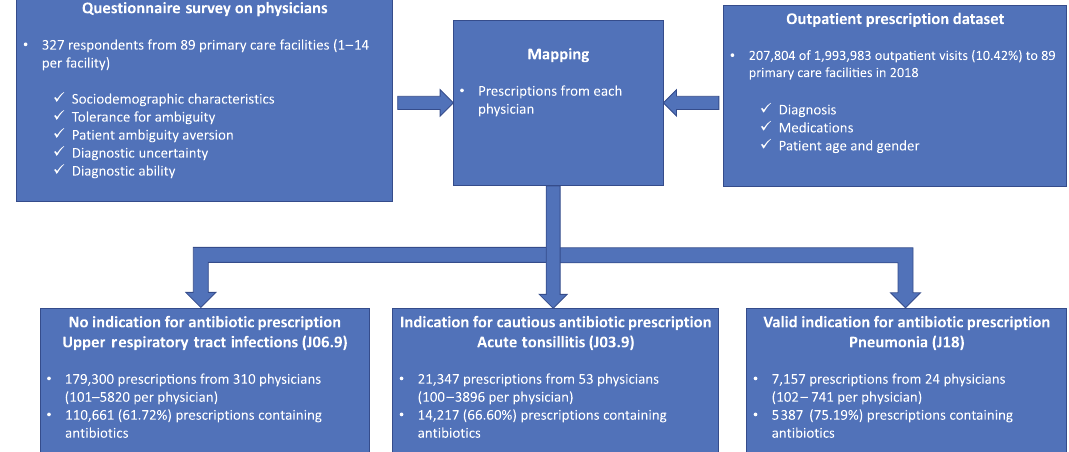
Fig. 1 Data collection and extraction procedure. This fi gure shows the current study design. Physicians ’ characteristics regarding diagnostic uncertainty were collected by a questionnaire survey, and their antibiotic-prescribing behaviours in clinical practice were extracted from the outpatient prescription dataset. The surveyed characteristics of physicians were mapped with their prescriptions for three acute conditions commonly treated in primary care facilities, including upper respiratory tract infections, acute tonsillitis, and pneumonia with an unspeci fi ed organism. According to the guidelines, antibiotics are not recommended for URTIs, while cautious use of antibiotics can be applied for tonsillitis, and antibiotic prescriptions for pneumonia with an unspeci fi ed organism are recommended. These conditions have a varied likelihood of bacterial infection and are deemed sensitive to the physicians and patient tolerance of uncertainty.